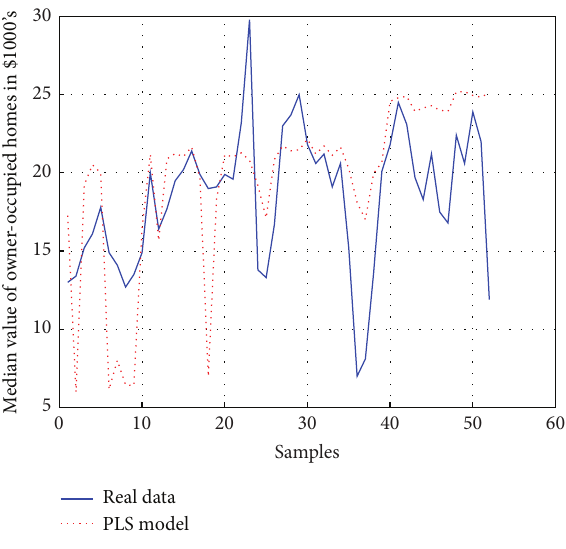
Figure 5: Forecasting results by